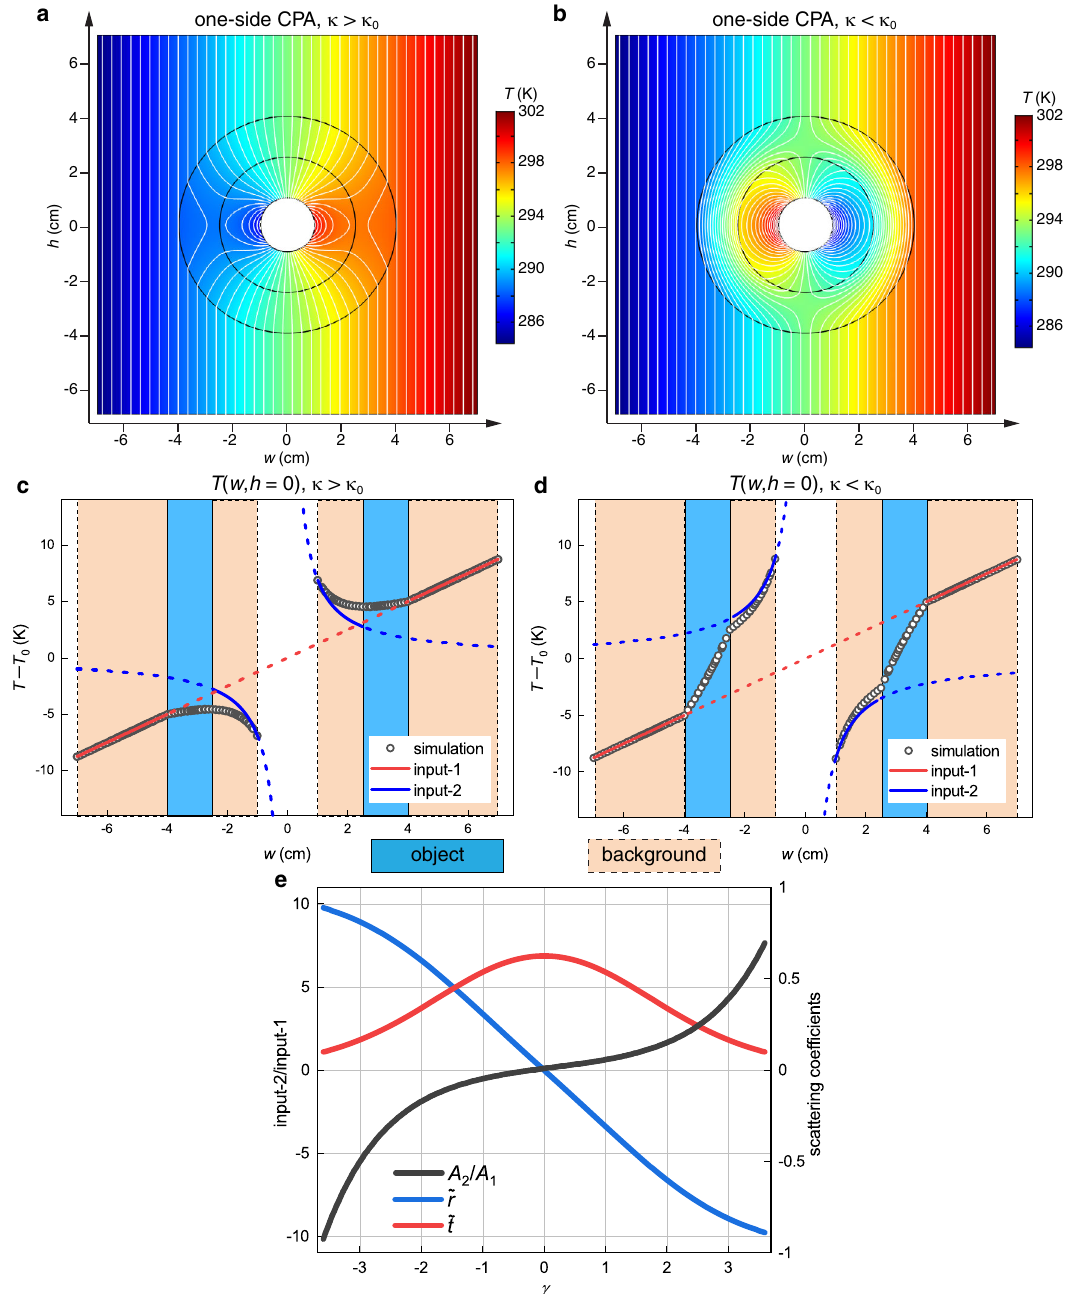
Fig. 3 Thermal one-side coherent perfect absorption (CPA). The ring-shaped object has an arbitrary thermal conductivity κ that is ( a , c ) larger or ( b , d ) smaller than that of the background κ 0 . a , b The temperature distributions on the entire system with isothermal lines (white). c , d Temperature distributions along the line h = 0. The regions of the background (beige) and the object (light blue) are shaded. The incident fi elds input-1 (red) and input-2 (blue) are also plotted. For one-side CPA only the fi eld outside the object meets the input fi eld. e The required inputs (black) and the re fl ection (blue) and transmission (red) coef fi cients for different combinations of the object and background